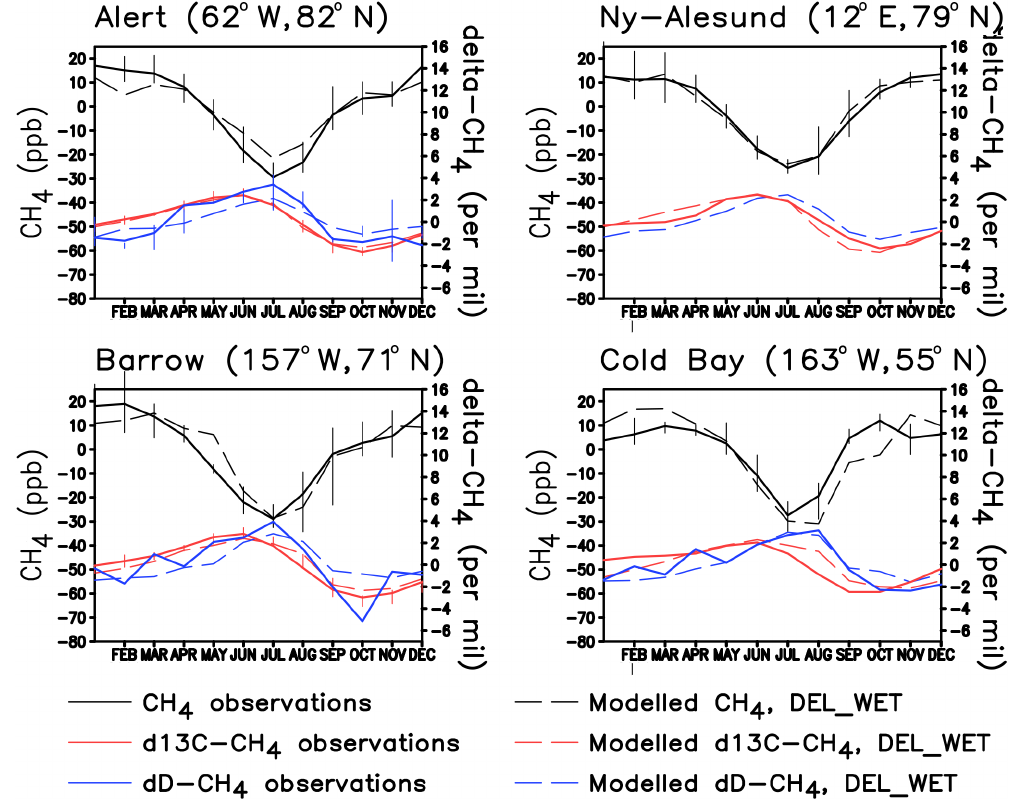
Figure 8. As Fig. 5, except showing model results from the DEL_WET scenario (where the seasonal cycle of wetland methane emissions from >50 ◦ N has been delayed by 1 month relative to BASE). δ D-CH 4 observations are not shown for Ny-Alesund due to insufficient data. Variations in δ 13 C-CH 4 have been multiplied by a factor of